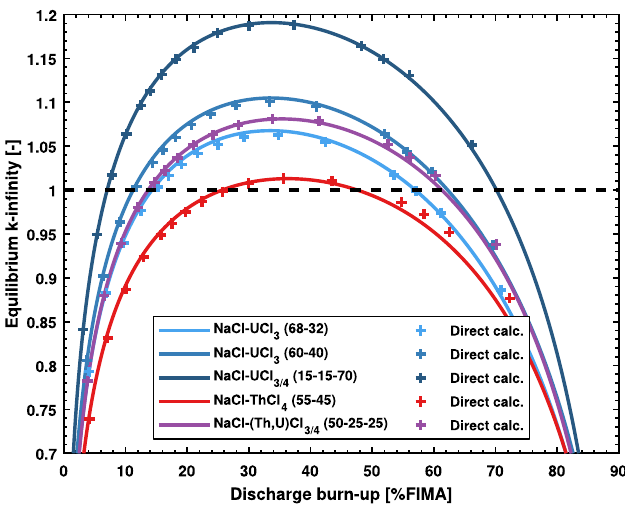
Fig. 4. Evaluation of the k ∞ at equilibrium using direct calculation (crosses) and the neutron excess method